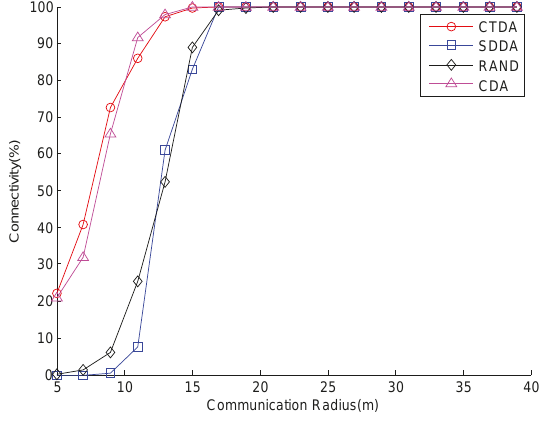
Figure 6. Connectivity with varying communication radii.